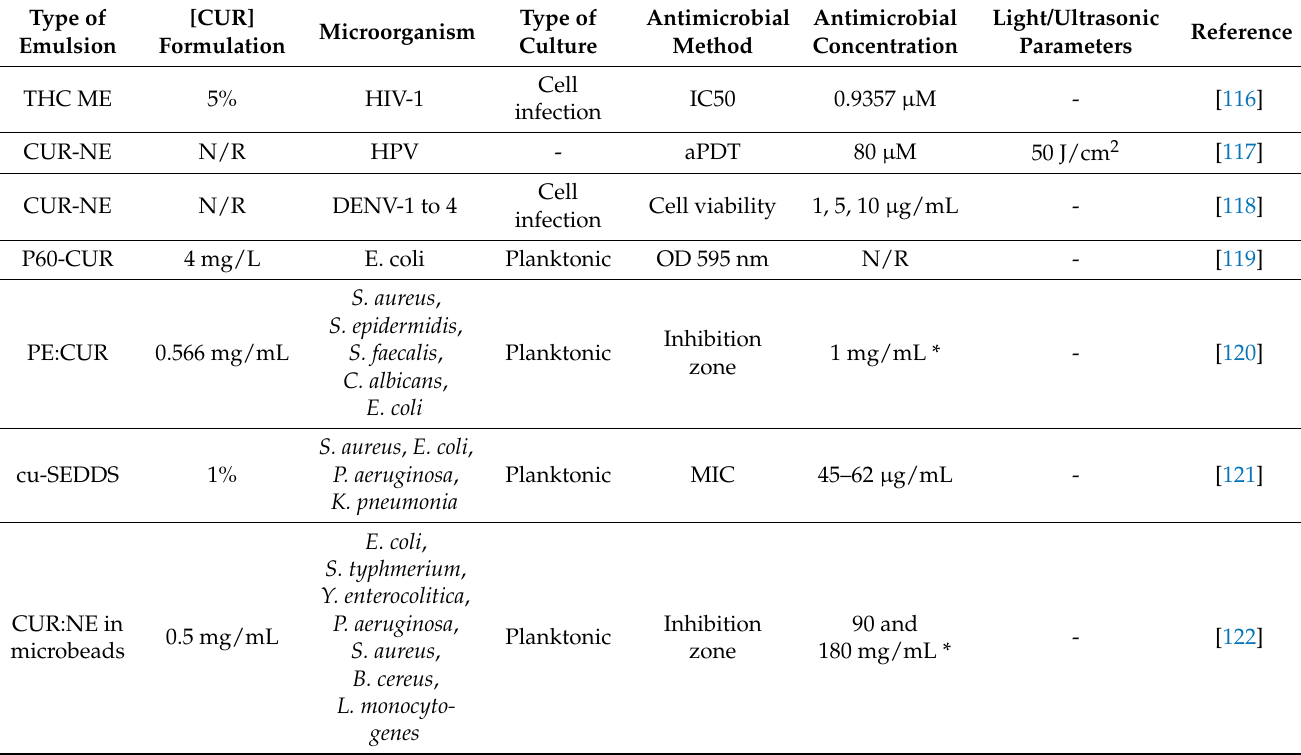
Figure 4. Schematic diagram of oil-in-water nanoemulsion ( A ) and water-in-oil nanoemulsion ( B ), stabilized by surfactants. Table 4. Antimicrobial studies performed with curcumin/curcuminoid in